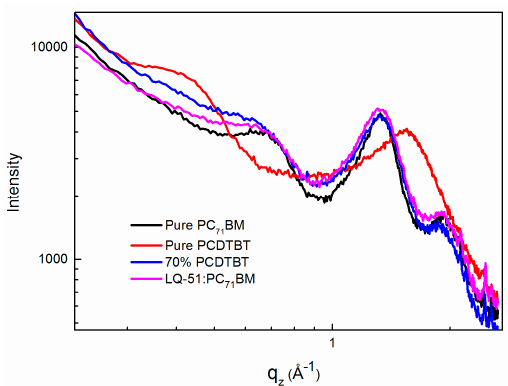
Figure 5. The out-of-plane grazing incidence X-ray diffraction (GIXRD) of pure PC 71 BM, pure PCDTBT, LQ-51/PC 71 BM binary film, and 70% PCDTBT-incorporated ternary